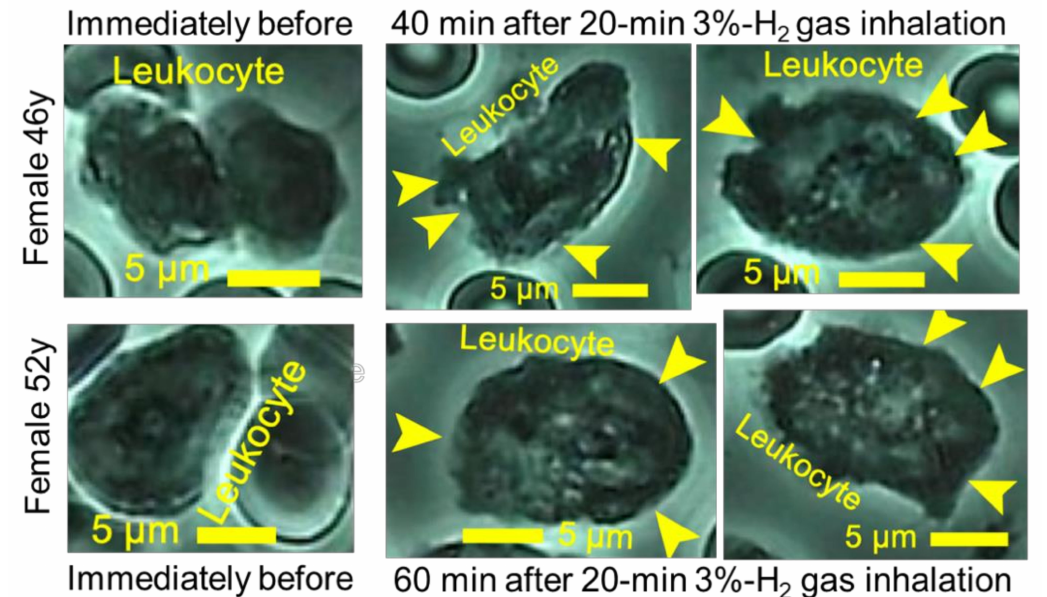
Figure 5. Promotive effects of hydrogen gas inhalation on leukocyte phagocytosis. The subjects of healthy females 46 and 52 years old inhaled 3% hydrogen gas for 20 min. Whole blood was collected immediately before the inhalation and at 40 or 60 min after the inhalation, and then filmed for 5 min under a microscope. The still images of huge numbers were prepared out of the video-graphs, and were analyzed for leukocytes existing at ratios as few as 1:800 to 1:1200 versus erythrocyte numbers. The microscopic photographs of leukocytes were shown together with yellow arrowheads indicating the foreign endogenous bodies which were distinguished from merely vacuoles or cysts.